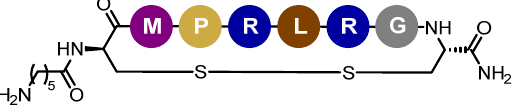
Figure 1. Structure of peptide-22.